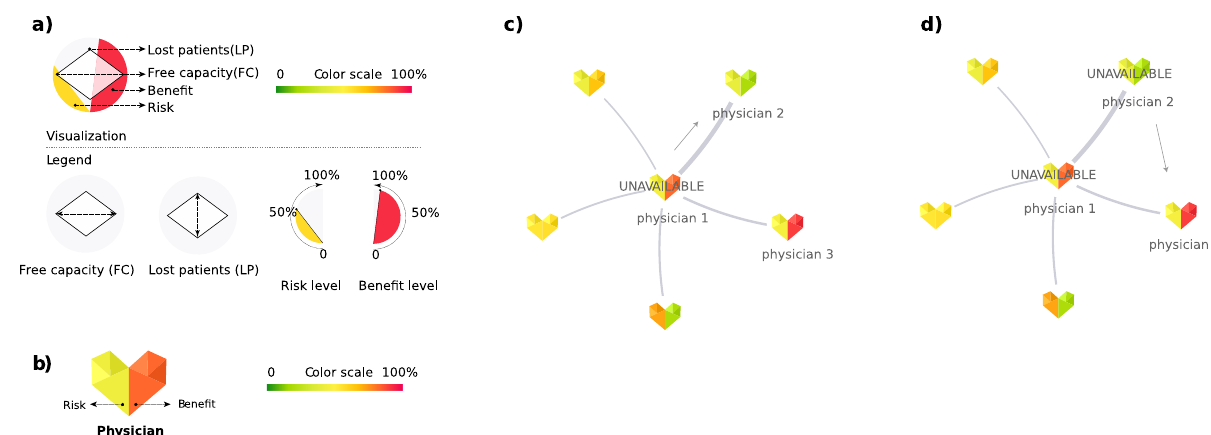
Fig. 1 Schematic overview of visualisation elements. a Custom glyph used to describe state-level results. b Custom glyph for aggregated specialty- or physician-speci fi c resilience indicators. c , d Example of physicians' patient-sharing network and patient displacement: ( c ) physician 1 becomes unavailable and a share of their patients try to re-locate to physician 2. As a result, physician 2 becomes unavailable as well ( d